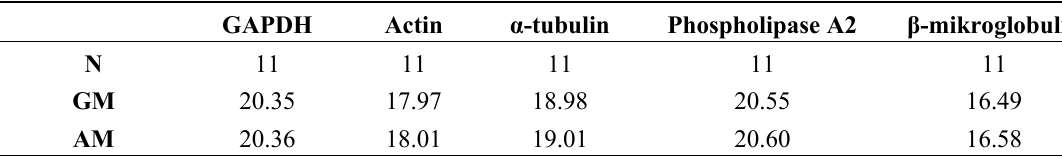
Table 1. Descriptive statistics of candidate human reference genes (RG) based on their crossing point (CP) values. Abbreviations: N: number of samples; GM: the geometric mean of CP; AM: the arithmetic mean of CP; Min CP and Max CP: the extreme values of CP; SD: the standard deviation of the CP; CV: the coefficient of variance expressed as a percentage on the CP